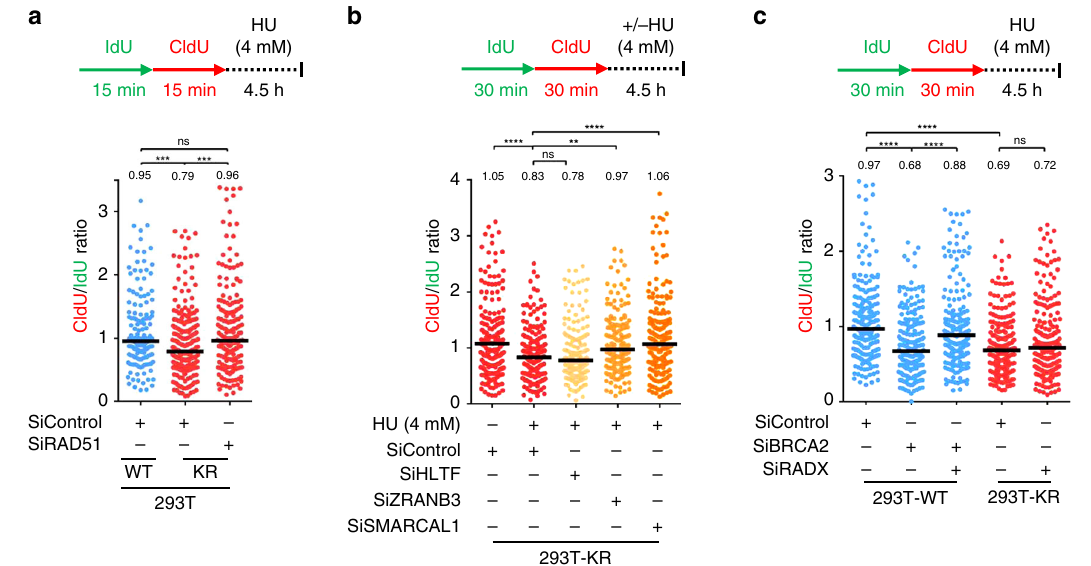
Fig. 3 Factors involved in fork reversal are required for nascent strand degradation in PCNA-K164R cells. a RAD51 depletion suppresses HU-induced nascent strand degradation in 293T-K164R cells. The ratio of CldU to IdU tract lengths is presented, with the median values marked on the graph and listed at the top. Asterisks indicate statistical signi fi cance (Mann – Whitney test, two-sided). A schematic representation of the fi ber combing assay conditions is also presented. A western blot showing RAD51 levels upon siRNA treatment is presented in Supplementary Fig. 5a. b Impact of DNA translocases HLTF, ZRANB3, and SMARCAL1 on HU-induced nascent strand degradation in 293T-K164R cells. The ratio of CldU to IdU tract lengths is presented, with the median values marked on the graph and listed at the top. Asterisks indicate statistical signi fi cance (Mann – Whitney test, two-sided). A schematic representation of the DNA fi ber combing assay conditions is also presented. Western blots con fi rming the knockdowns are shown in Supplementary Fig. 5b. c Knockdown of RADX suppresses HU-induced nascent strand degradation in BRCA2-de fi cient cells, but not in 293T-K164R cells. The ratio of CldU to IdU tract lengths is presented, with the median values marked on the graph and listed at the top. Asterisks indicate statistical signi fi cance (Mann – Whitney test, two-sided). A schematic representation of the assay conditions is also presented. Con fi rmation of RADX knockdown is shown in Supplementary Fig. 5d. Source data are provided as a Source Data fi